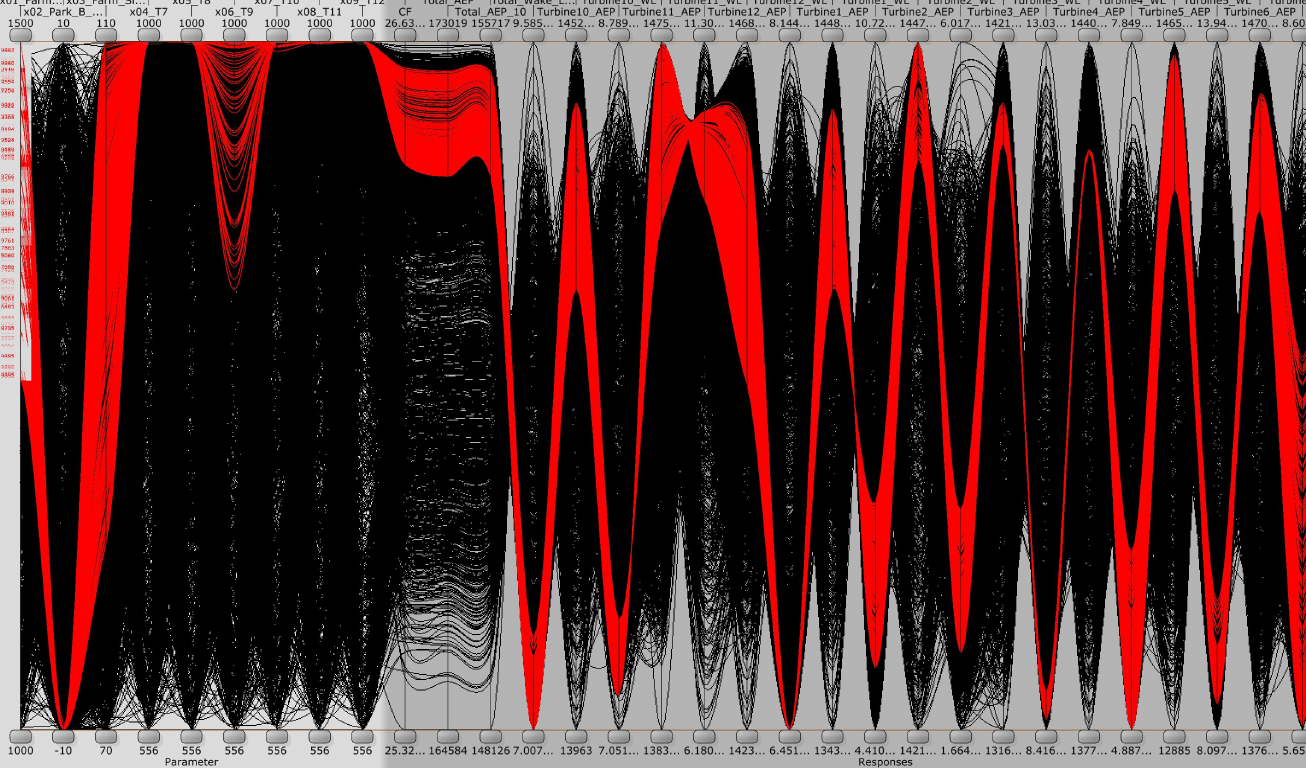
8 of 15 Table 2. Taguchi orthogonal array L54 matrix and results with respect to the nine design variables.